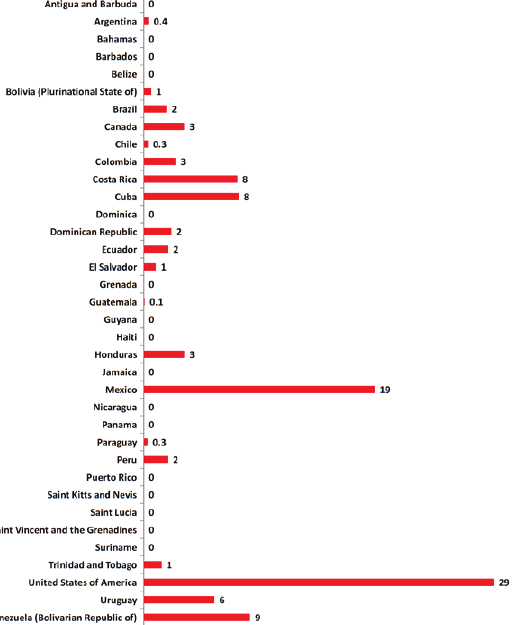
Figure 8: Percent of total cultivated area drained (%) in 2011 (in few cases due to lack of data, value of the index in the previous years has been reported)